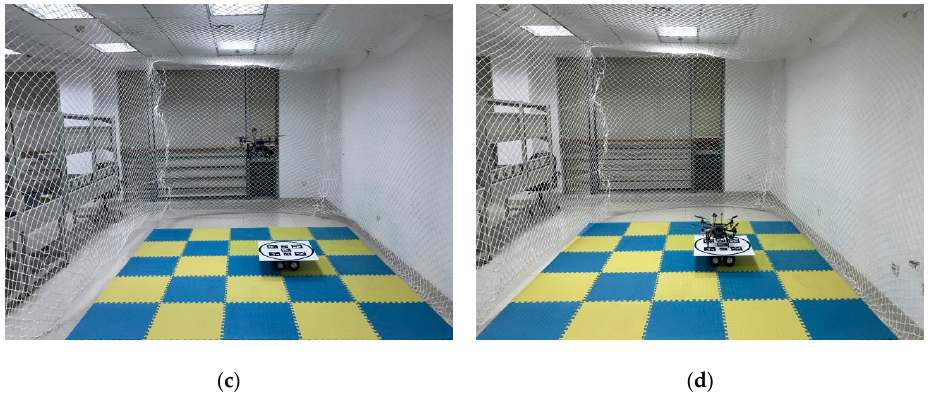
Figure 11. Autonomously approaching ( a,b ), descending ( c ), and landing on a static landing pad ( d ).